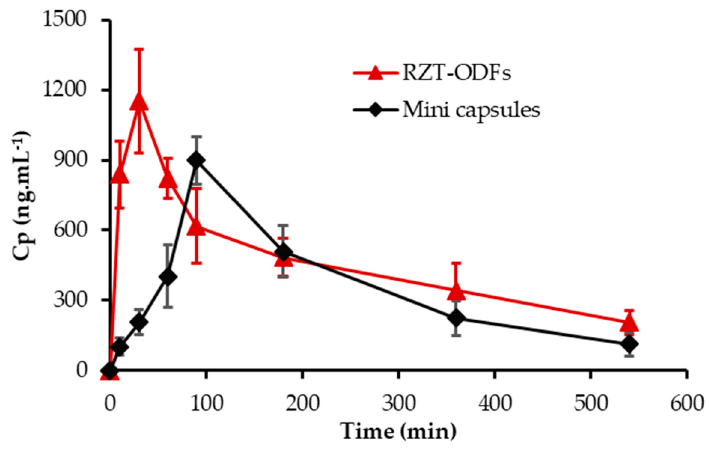
Figure 14. Pharmacokinetic profile of optimized RZT-ODFs and marketed product. Data expressed as average ± SD ( n = 6). Table 2. Pharmacokinetic parameters of optimized formulation and marketed product.